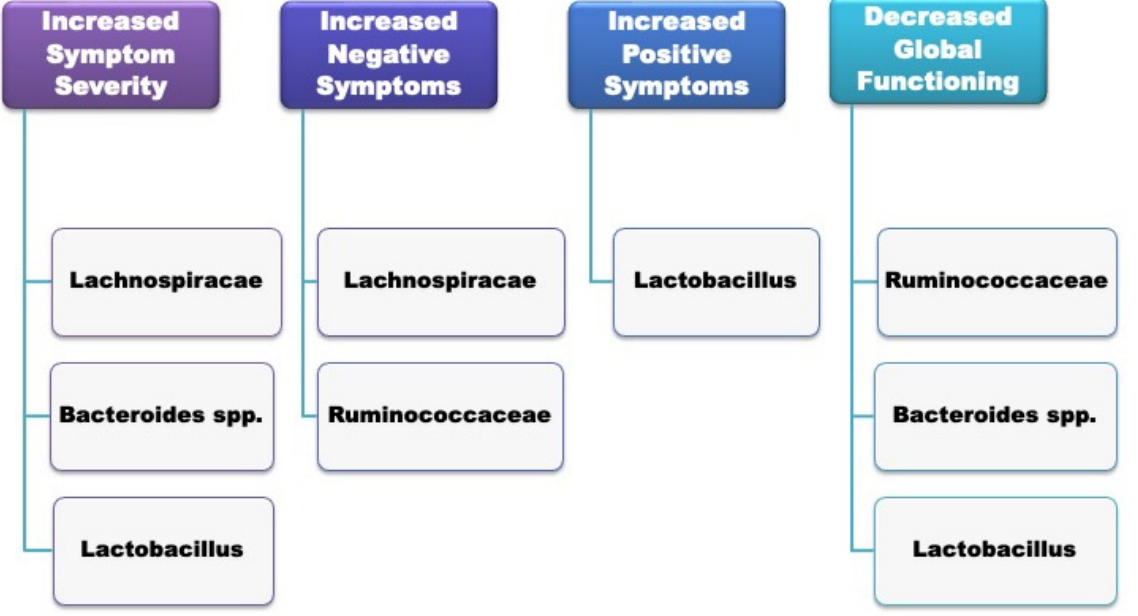
Figure 1. Gut microbiome composition and clinical features of the first episode of psychosis (FEP).